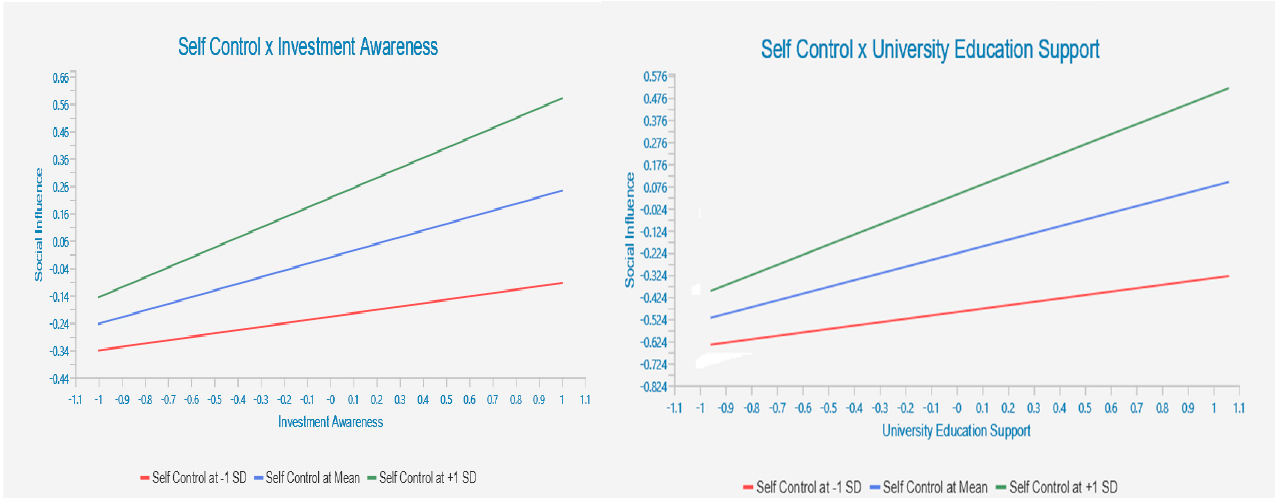
Figure 3. Simple slope analysis.